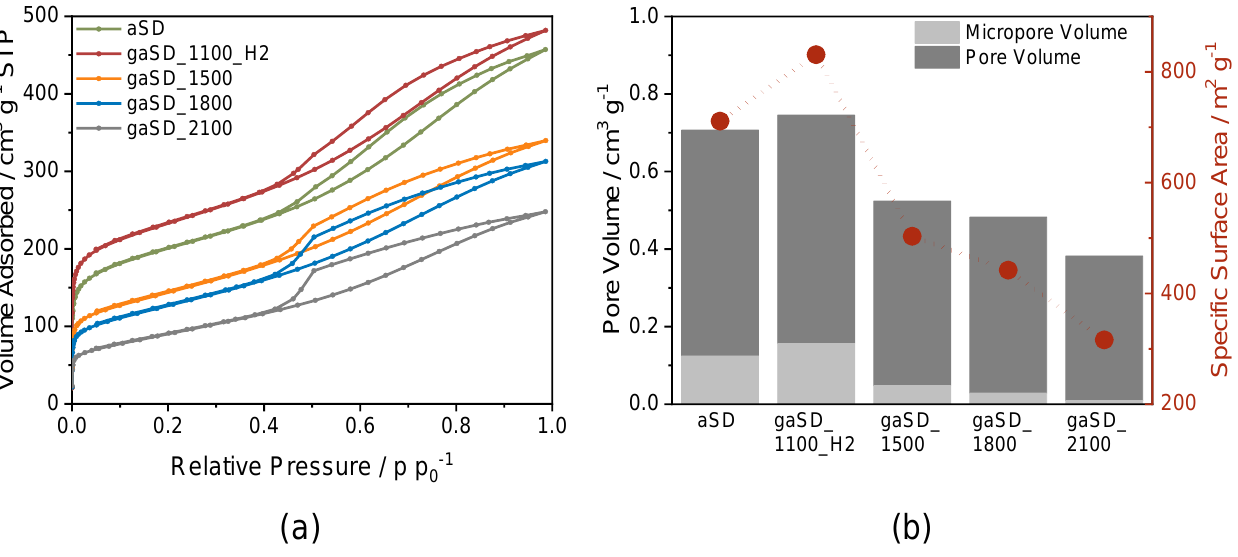
Figure 2. ( a ) Nitrogen sorption isotherms and ( b ) specific surface area and micro − /pore volume of untreated and thermally treated activated sawdust.